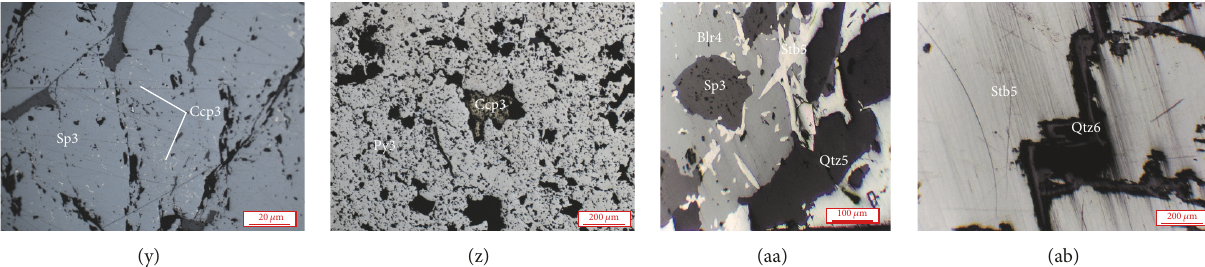
Figure 4: Hand specimen photographs and photomicrographs of representative samples from the Zhaxikang deposit. (a) Stage 1 lamellar sphalerite-pyrite-arsenopyrite and stage 2 massive sphalerite-pyrite hosted within fine-grained Mn-Fe carbonate. (b) Stage 1 lamellar and stage 2 banded Mn-Fe carbonate-sphalerite-galena ore with visible synsedimentary features including rhythmic sedimentation in the upper part and angular folding in the lower part of the sample. (c) Stage 1 lamellar sphalerite-pyrite-arsenopyrite and stage 2 massive and